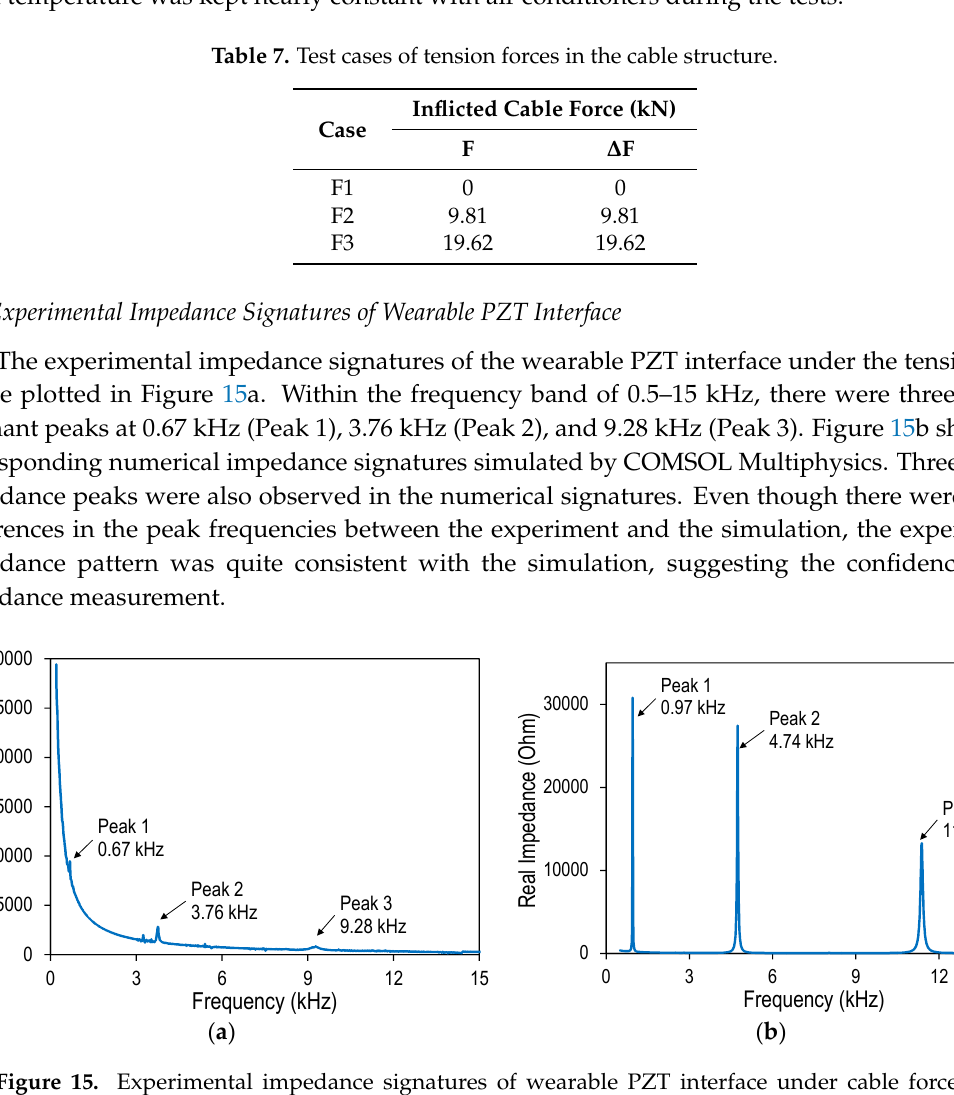
Figure 14. Experimental setup of lab-scale cable structure: ( a ) schematic of test setup; ( b ) cable equipped with wearable PZT interface; ( c ) attachment method. Table 7. Test cases of tension forces in the cable structure.